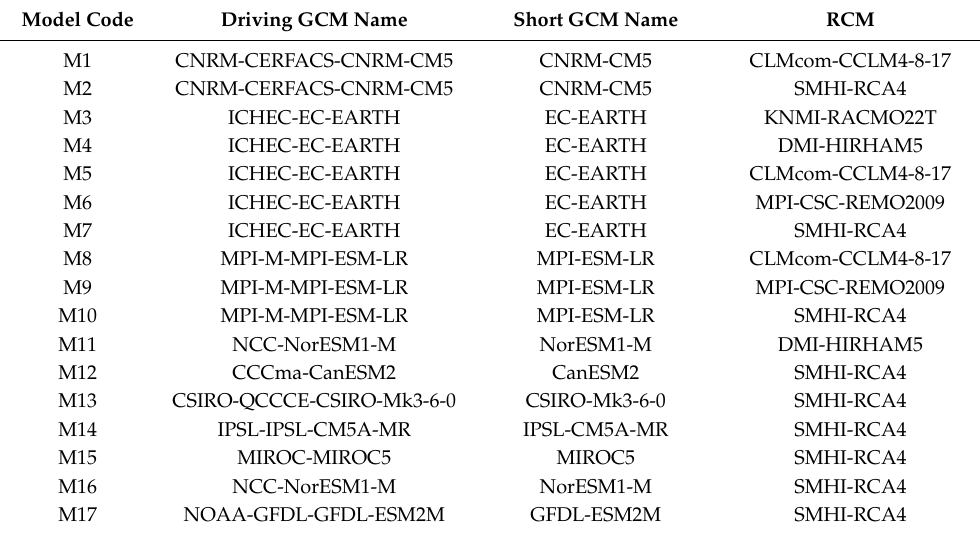
Table 1. The list of climate models that have been collected from the CORDEX-Africa